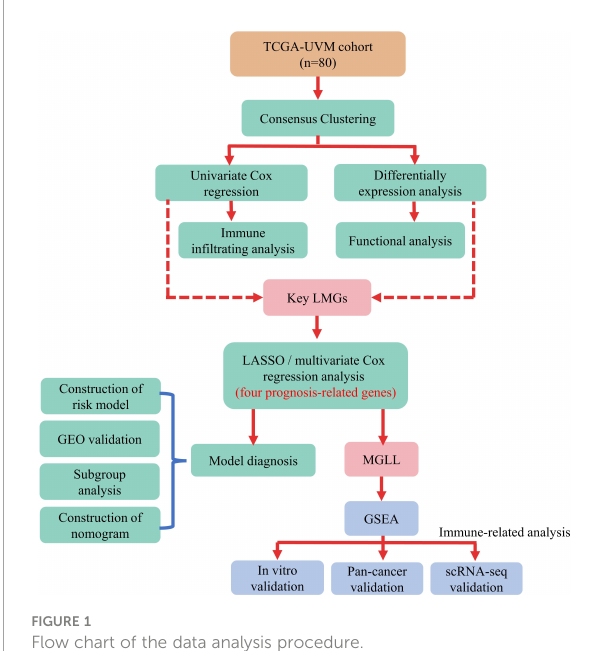
FIGURE 1 Flow chart of the data analysis